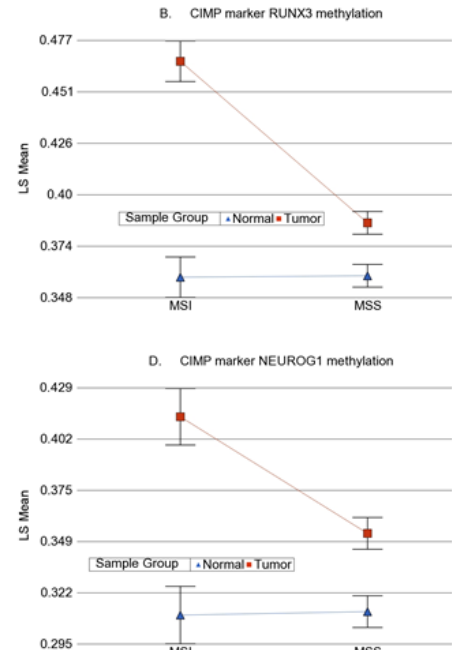
Figure 6. Methylation status of CIMP genes in the tumor (red) and normal (blue) in MSI and MSS. All 107 loci covering these genes commonly used for the detection of CIMP phenotype are shown. Changes in the MSI and MSS are shown in A and B respectively.